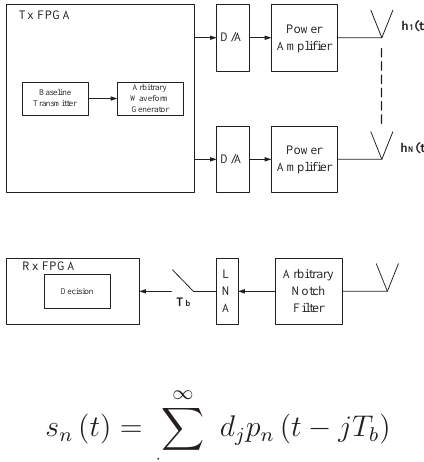
Figure 33. System